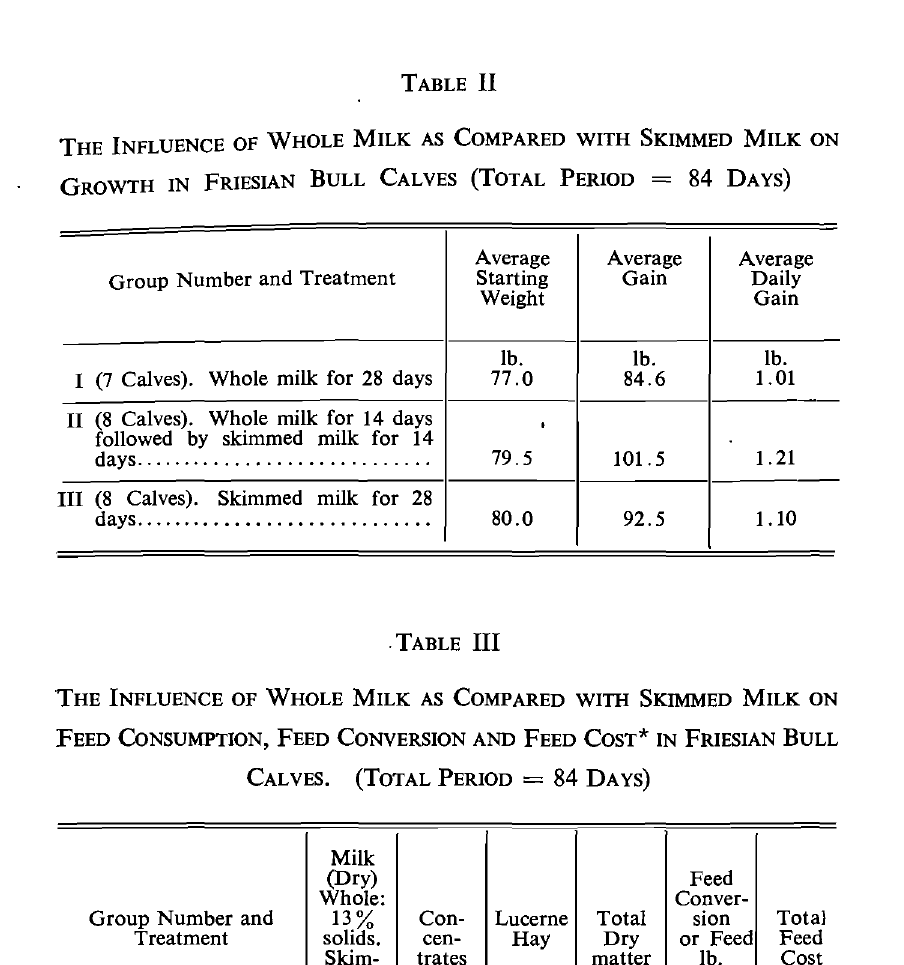
THE INFLUENCE OF WHOLE MILK AS COMPARED WITH SKIMMED MILK ON GROWTH IN FRIESIAN BULL CALVES (TOTAL PERIOD = 84 DAYS)